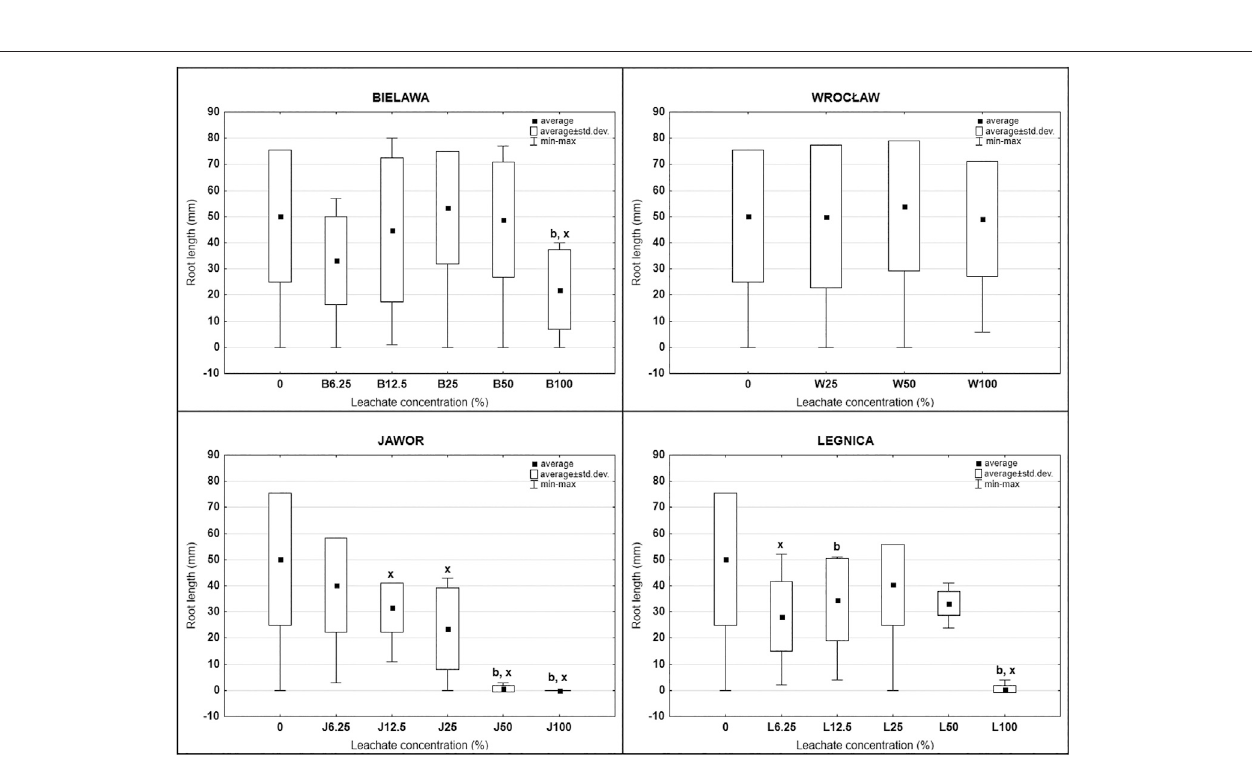
FIGURE 4 | Characteristic values (mean, standard deviation, minimum, maximum) for root length measurement results-series 12.2019.